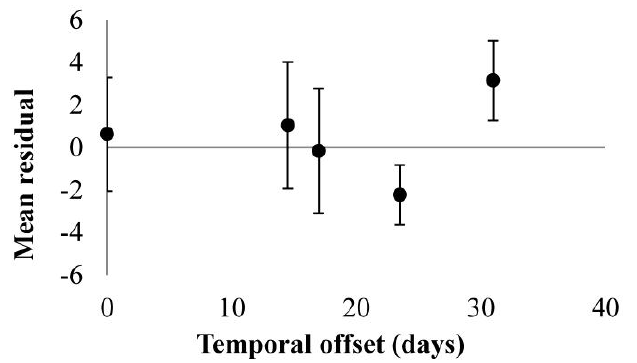
Figure 4. Model uncertainty analysis results. Our model was tested on four additional scenes where in situ NTU C values could be compared to model estimates. The data points show that the greater the temporal offset, the greater the uncertainty in the model estimates as indicated by the inflation of the mean